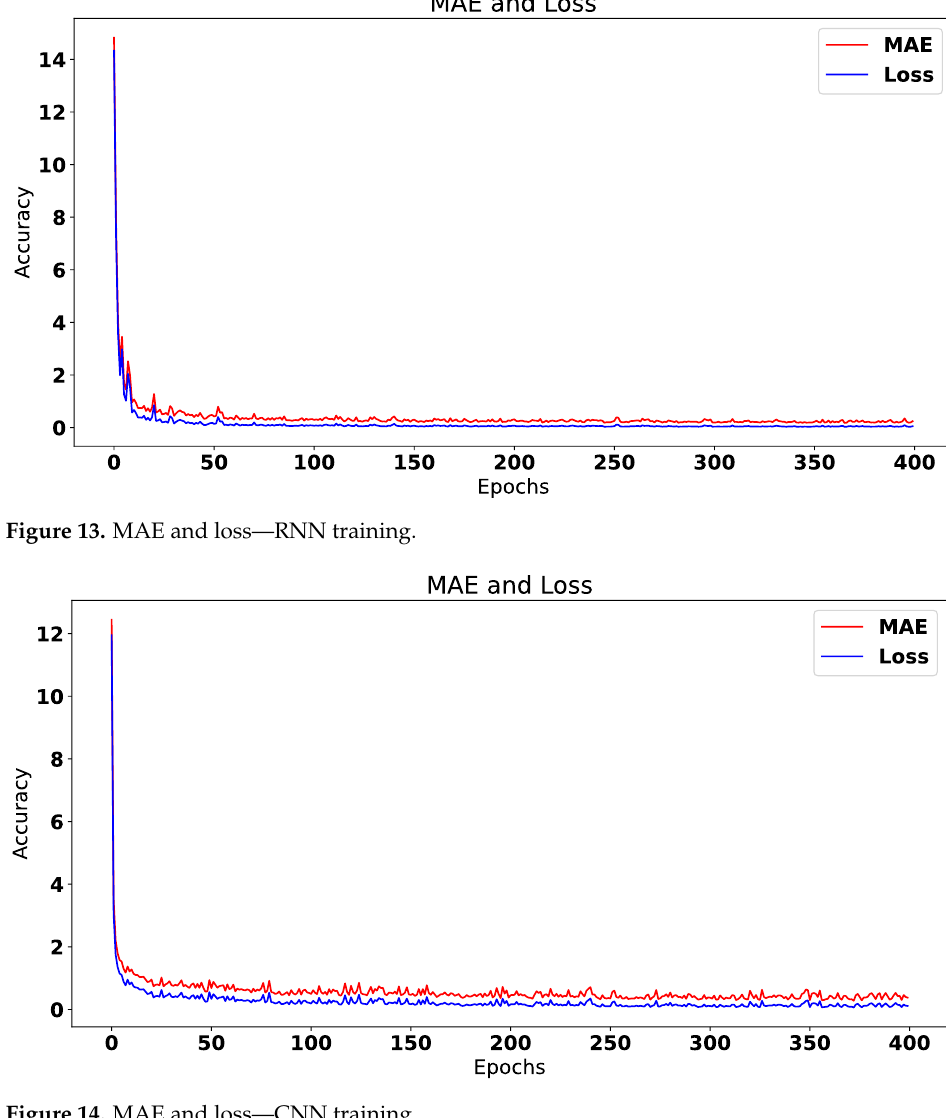
Figure 14. MAE and loss - CNN training